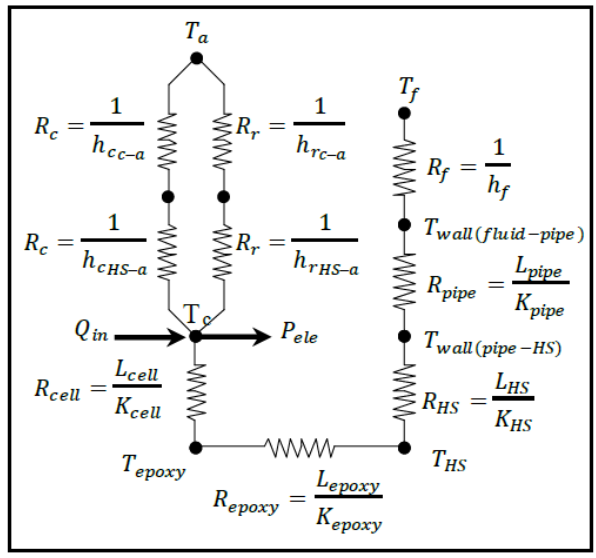
Figure 5. Thermal resistance diagram corresponding to the CPVT assembly layers.